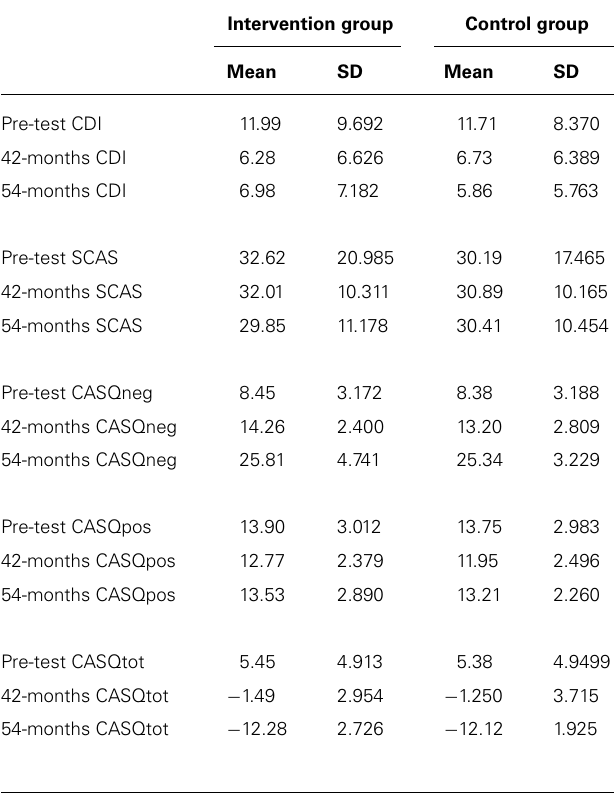
Table 3 | Mean (SD) at pre-test, 42-month, and 54-month follow-up for intervention and control groups for each outcome measure. Intervention